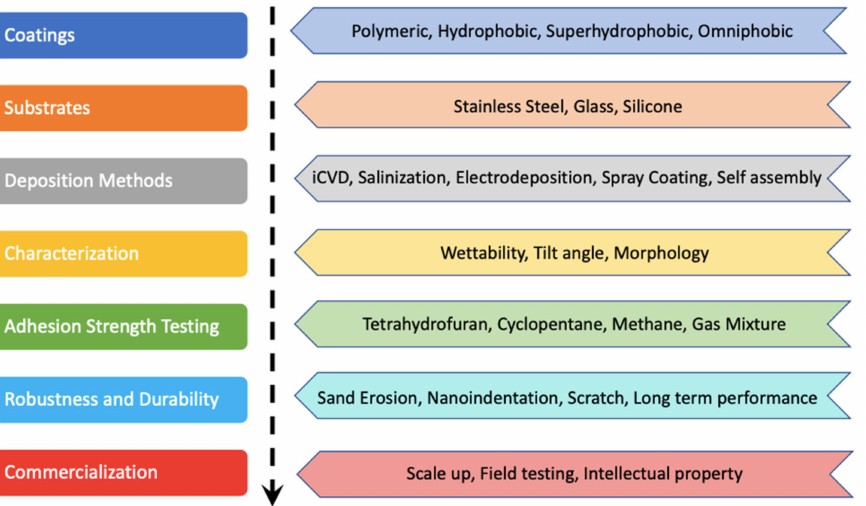
Figure 5. From concept to commercialization: Development stages of an anti-hydrate/hydrate- phobic